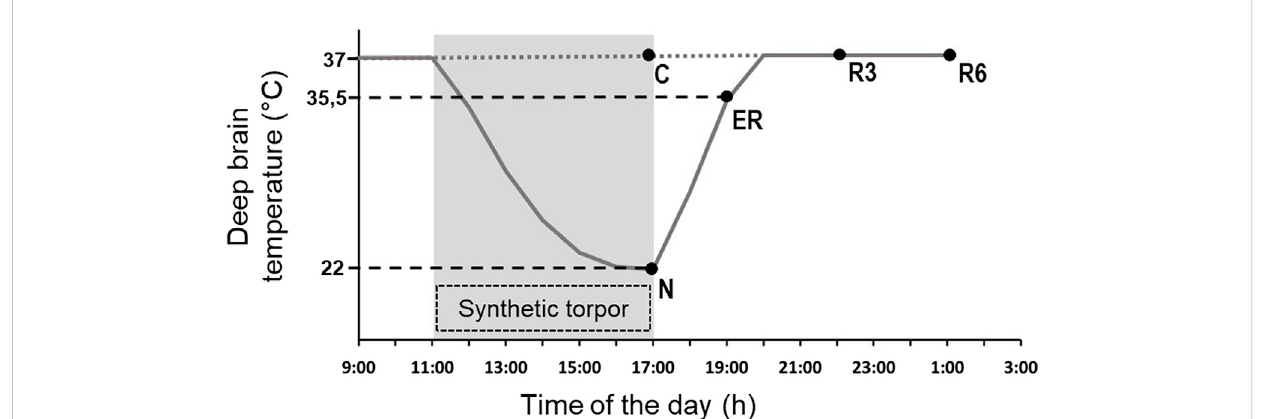
FIGURE 1 Schematic representation of the experimental conditions. The solid line indicates the progress of deep brain temperature (Tb) throughout the experiment. The dotted line refers to the control group (C; i.e., injected with arti fi cial cerebrospinal fl uid). The shaded area represents the period when synthetic torpor (ST) was induced (i.e., by injecting muscimol within the Raphe Pallidus). N, samples taken at nadir of hypothermia, during ST; ER, early recovery, samples taken when Tb reached 35.5 ° C following ST; R3, samples taken 3 h after ER; R6, samples taken 6 h after ER. See Methods for